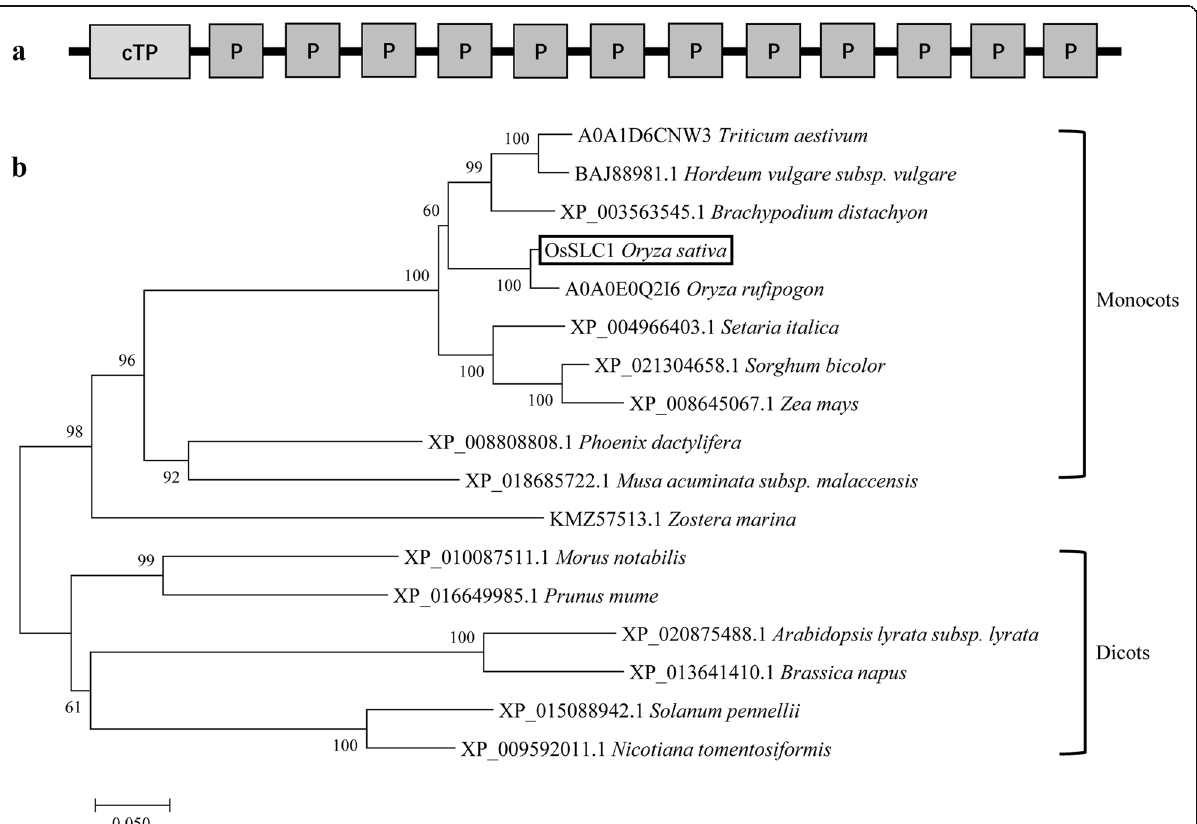
Fig. 5 Structure and phylogenetic analysis of OsSLC1. a Predicted structure of OsSLC1. OsSLC1 contains a chloroplast transit peptide (cTP) and 12 PPR motifs (P). b Phylogenetic tree of OsSLC1 and its homologs. The protein sequences of A0A1D6CNW3 ( Triticum aestivum ) and A0A0E0Q2I6 ( Oryza rufipogon ) were downloaded from the UniProt database; all other sequences were downloaded from the National Center for Biotechnology Information